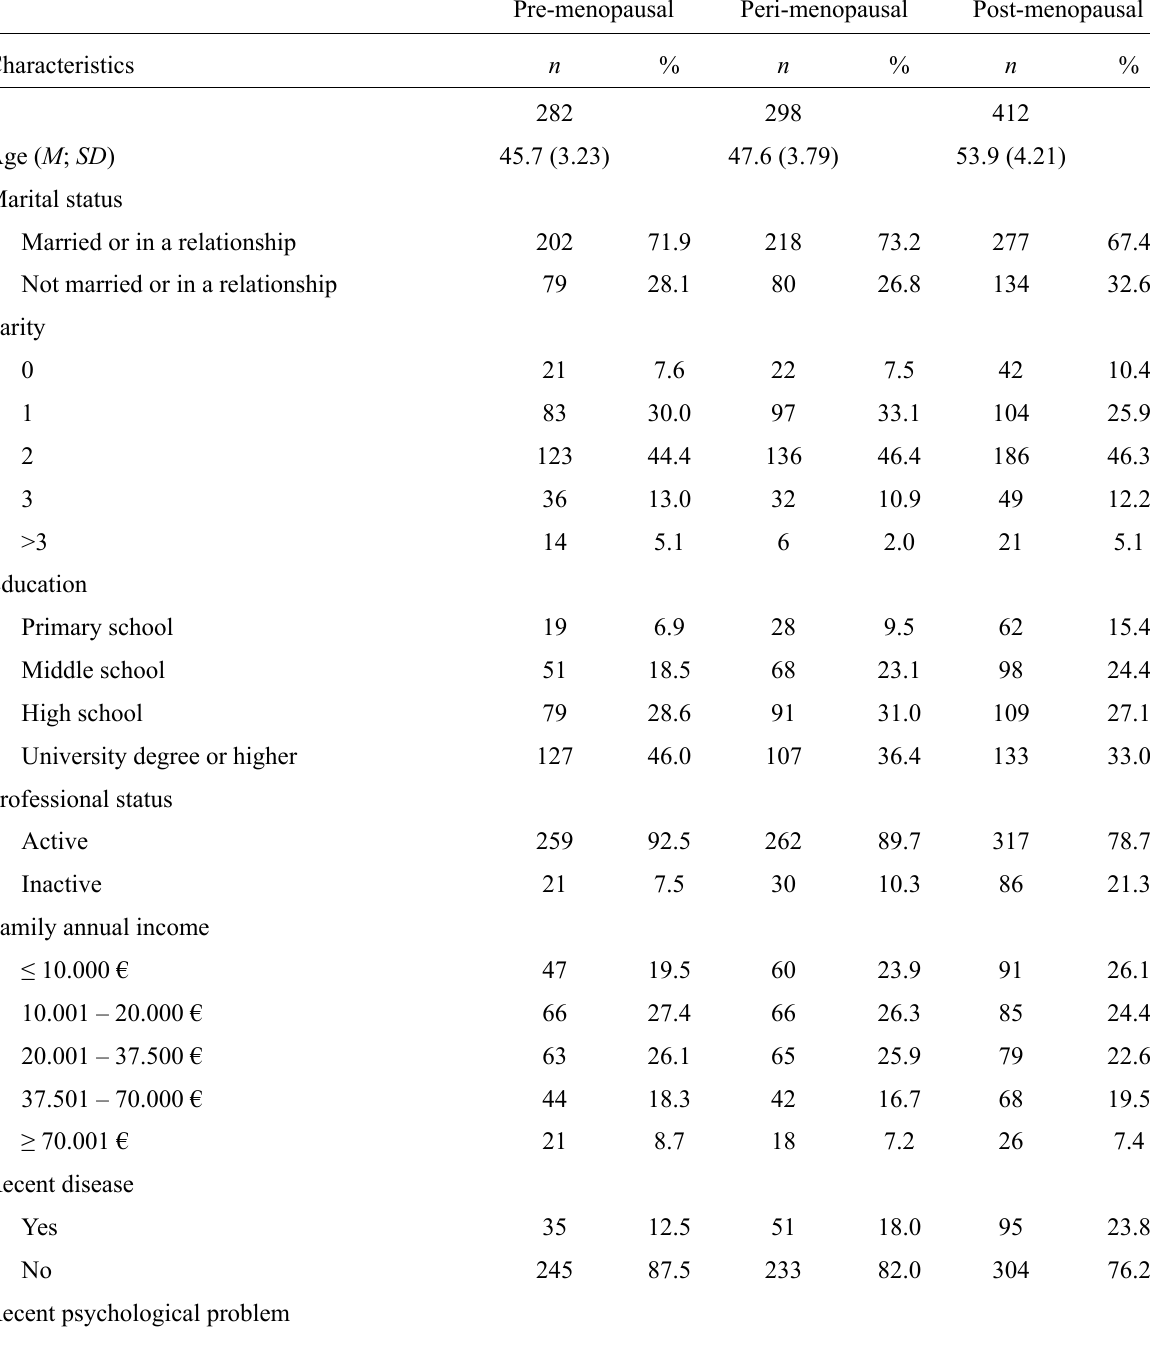
Characterization of the Participants in Relation to Socio-Demographic, Health and Menopause-Related and